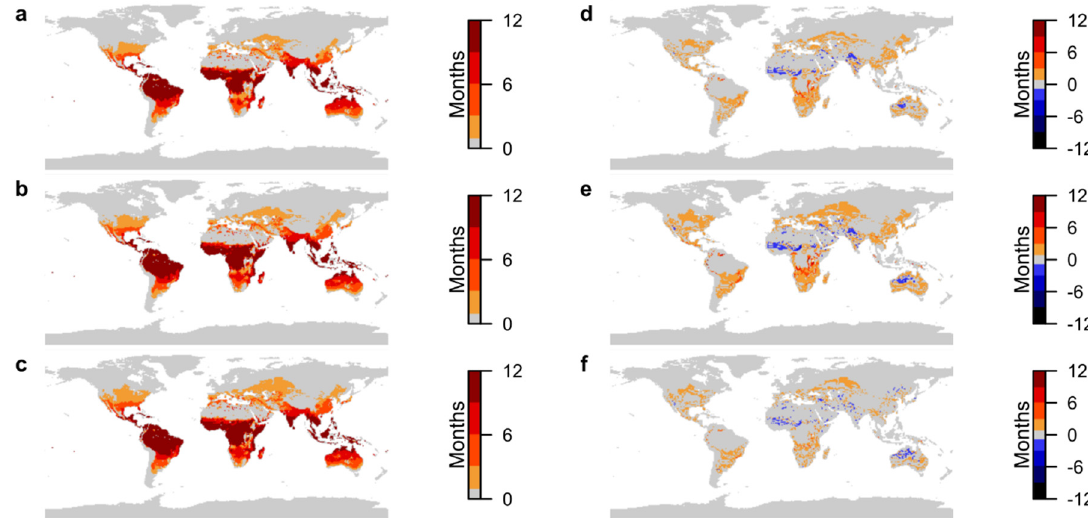
Figure 2. Projections of transmission suitability for Zika virus. ( a ) Number of months of transmission suitability in present day; ( b ) number of months of transmission suitability in 2050 under SSP1-2.6; ( c ) number of months of transmission suitability in 2050 under SSP5-8.5; ( d ) change in number of months of transmission suitability from present day to 2050 under SSP1-2.6; ( e ) change in number of months of transmission suitability from present day to 2050 under SSP5-8.5; ( f ) difference in number of months of transmission suitability in 2050 between SSP5-8.5 and SSP1-2.6. For ( a – c ), colour-bar scales are set so that increasing intensity of red depicts areas where transmission suitability is marginal (1–3 months), moderate (4–6 months), seasonal (7–9 months) and endemic (10–12 months). For ( d – f ), colour-bar scales are similarly grouped, with increasing intensity of red depicting increases in transmission suitability of 1–3 months, 4–6 months, 7–9 months and 10–12 months, and increasing intensity of blue depicting the equivalent decreases. Only areas where differences are statistically significant at the 95% confidence level are